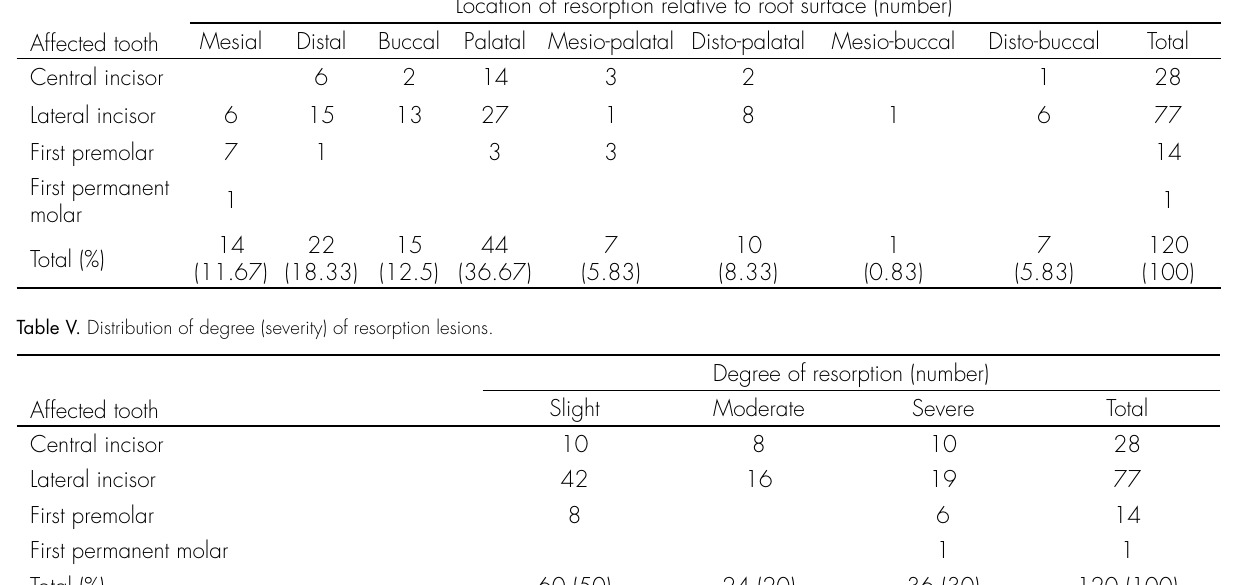
Table IV. Distribution of resorption lesions relative to root surface.